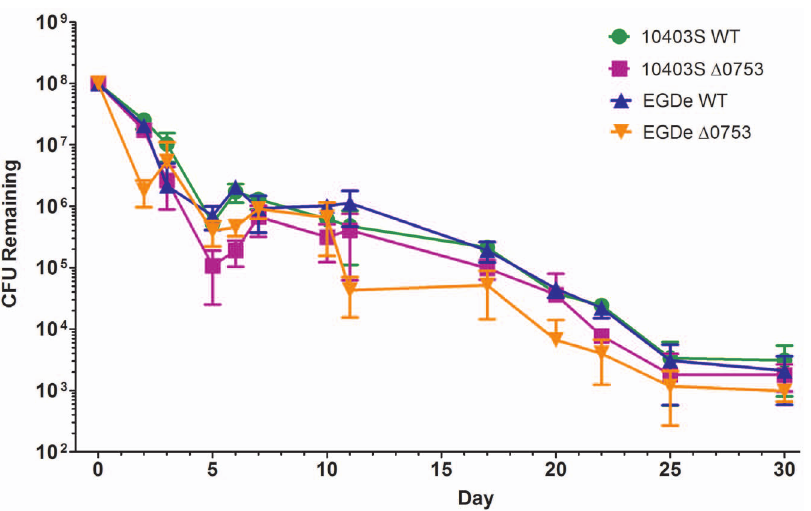
Figure 4. L.monocytogenes soil survival. Bacterial survival in potting soil at 25 u C for 30 days. Standard deviations represent three independent experiments performed in triplicate.